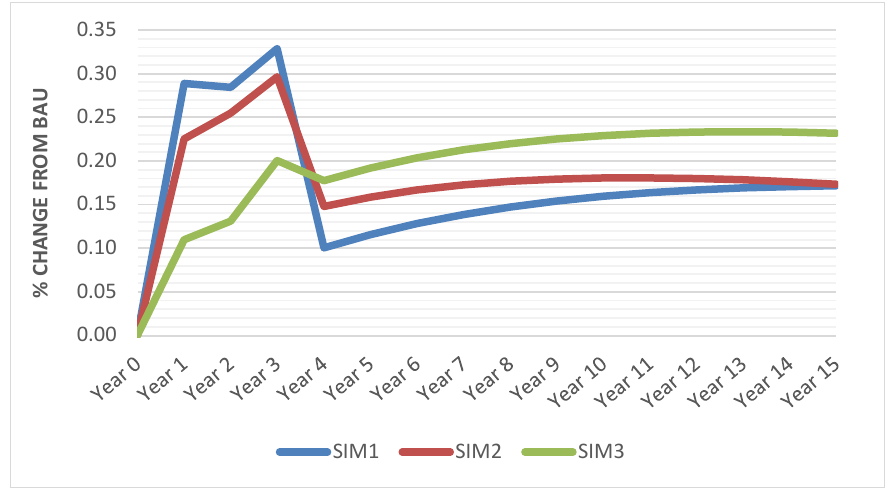
FIGURE 3: Impact of increasing public infrastructure on GDP (% change from BAU) Source: Authors’ calculations from simulation results